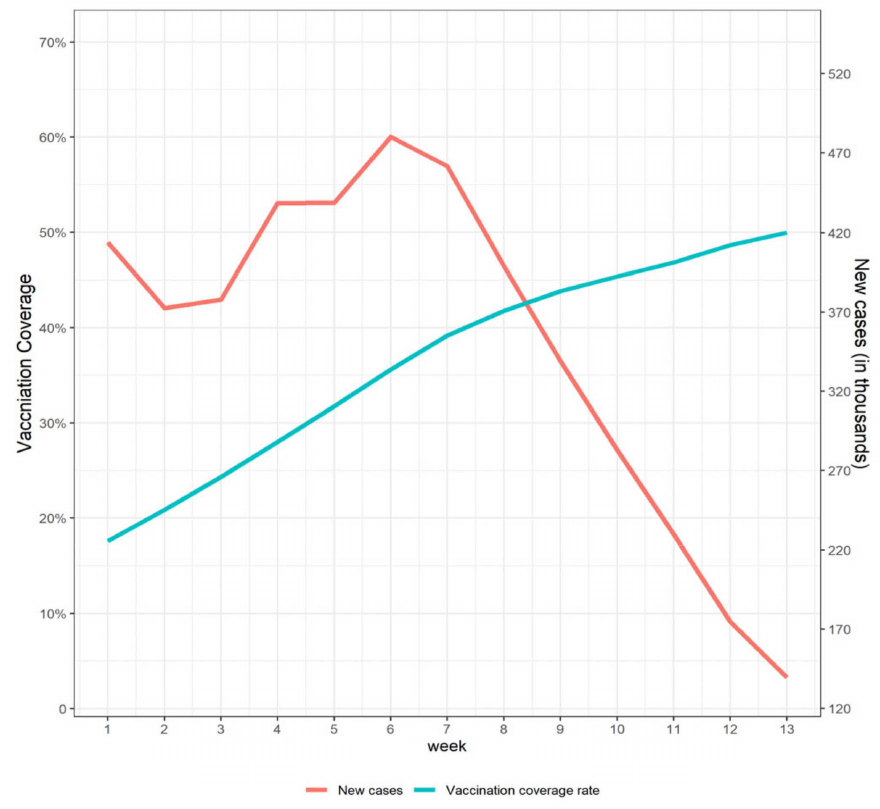
Figure 1. Vaccination coverage and new cases (in thousands) in the United